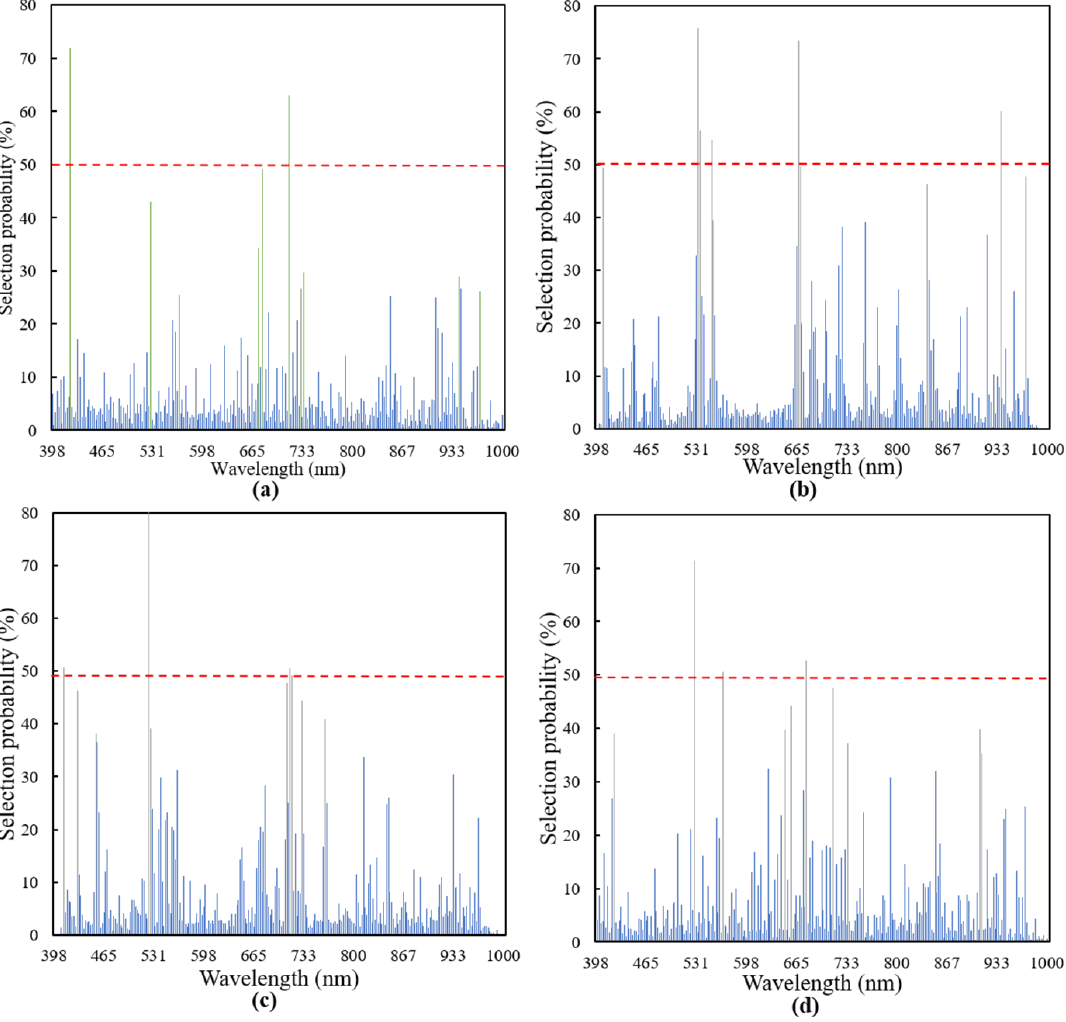
Figure 4. SFLA screening results: ( a ) OR-SPA, ( b ) SG-FDR-SPA, ( c ) SG-SDR-SPA, and ( d ) SNV- SPA.